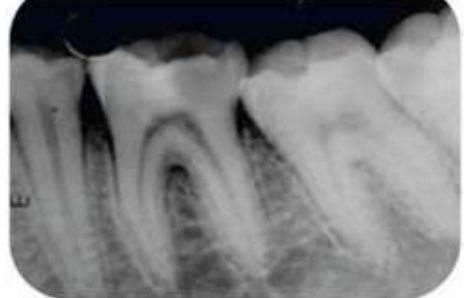
Figure 1: Preoperative radiograph of right mandibular first molar